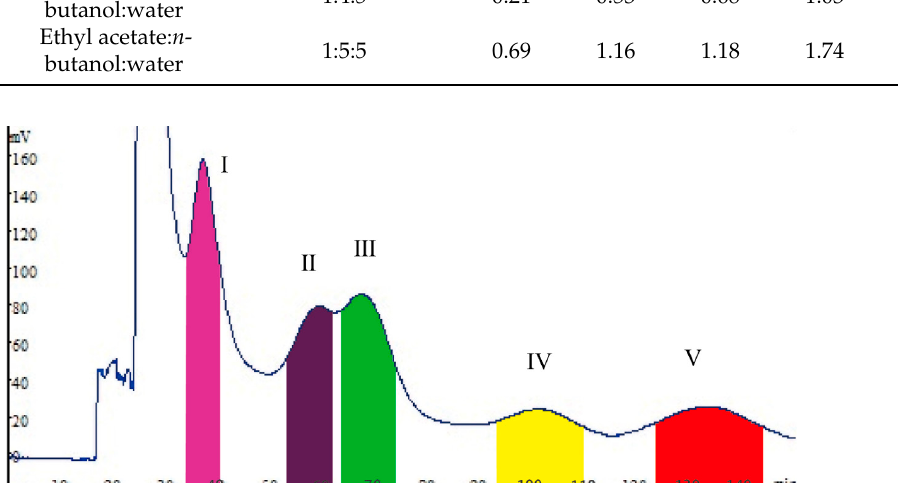
Table 1. The K values of target compounds in HSCCC separation with different solvent systems.